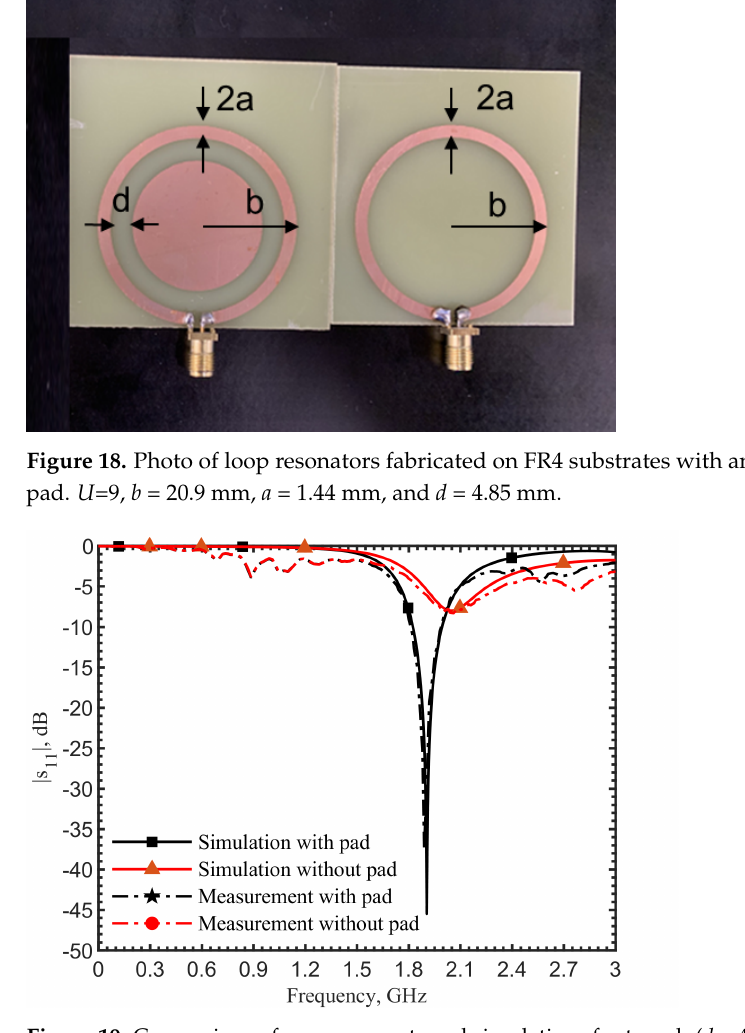
Figure 19. Comparison of measurements and simulations for tuned- ( d = 4.85 mm) and untuned-loop resonators on FR4 substrates with a 1.5 mm